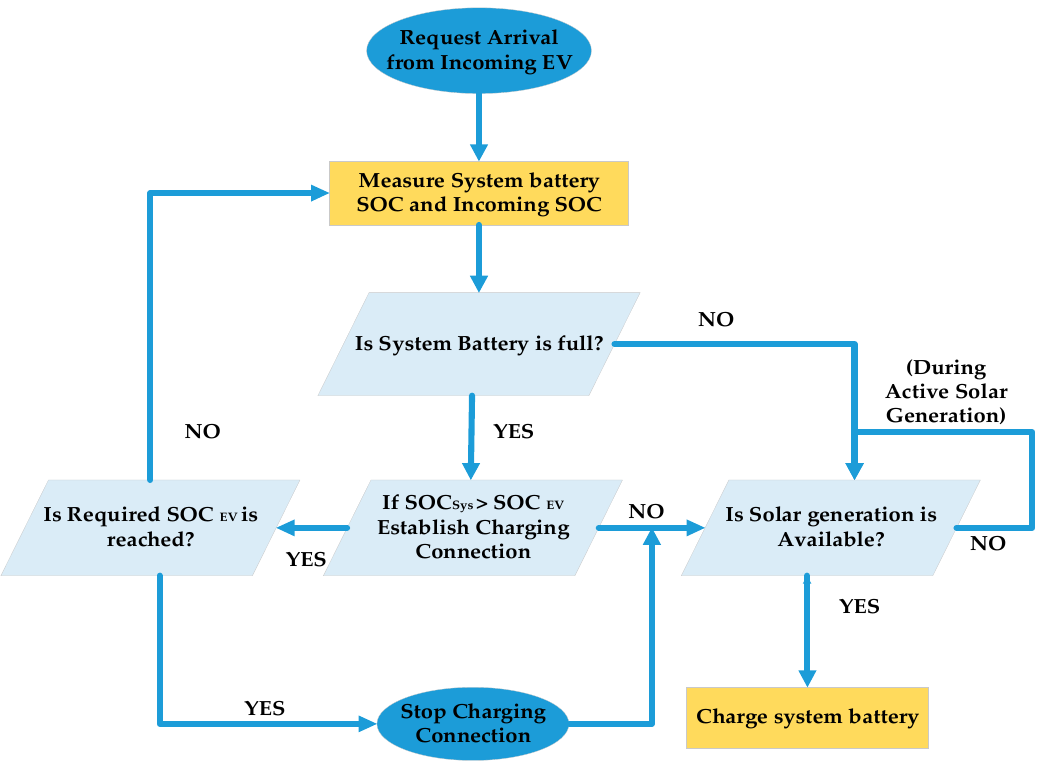
Figure 11. Proposed algorithm for SPRCS.